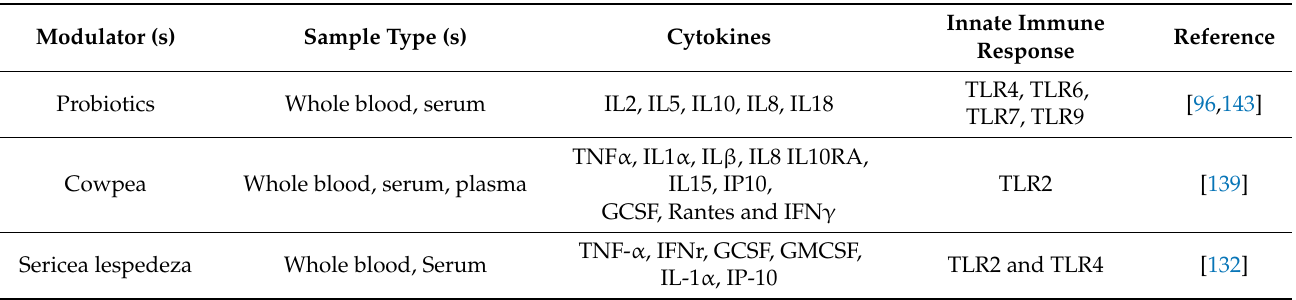
Table 3. Selected immunomodulators tested in goat